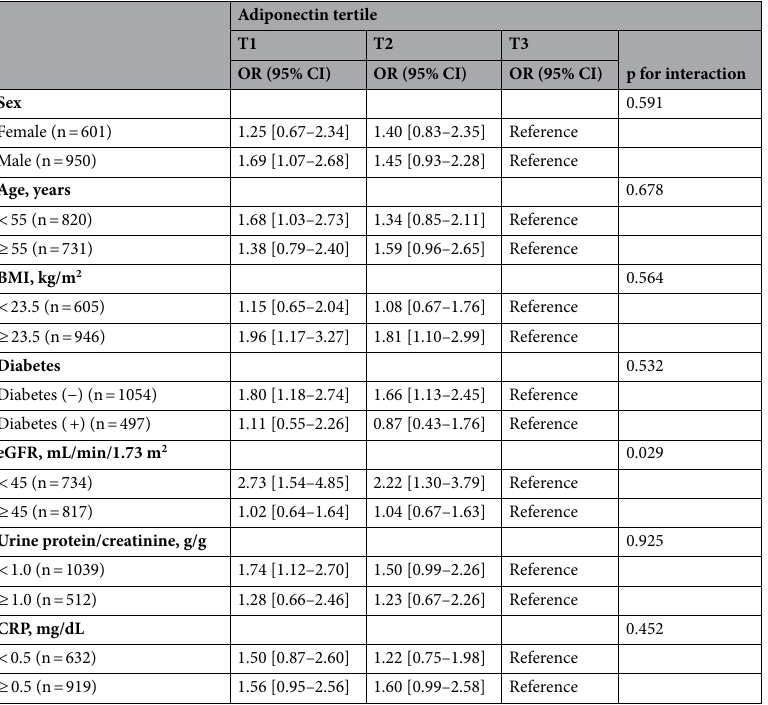
Table 4. Association between serum adiponectin tertile and high PCS in clinically relevant subgroups. BMI body mass index; eGFR estimated glomerular filtration rate; CRP C-reactive